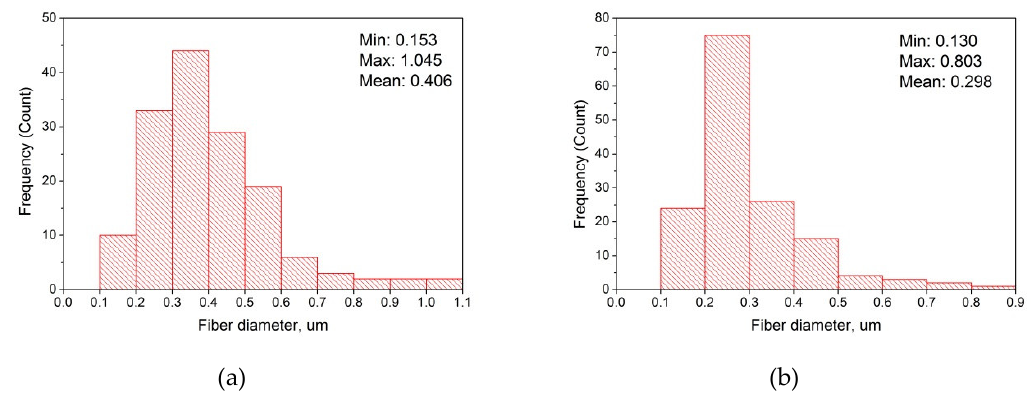
Figure 7. Diameter distribution of curcumin/usnic acid-loaded fibers based on hyaluronic acid: ( a ) under 22 kV; ( b ) under 28 kV. Note, than for measuring diameter distribution the several images were utilized.